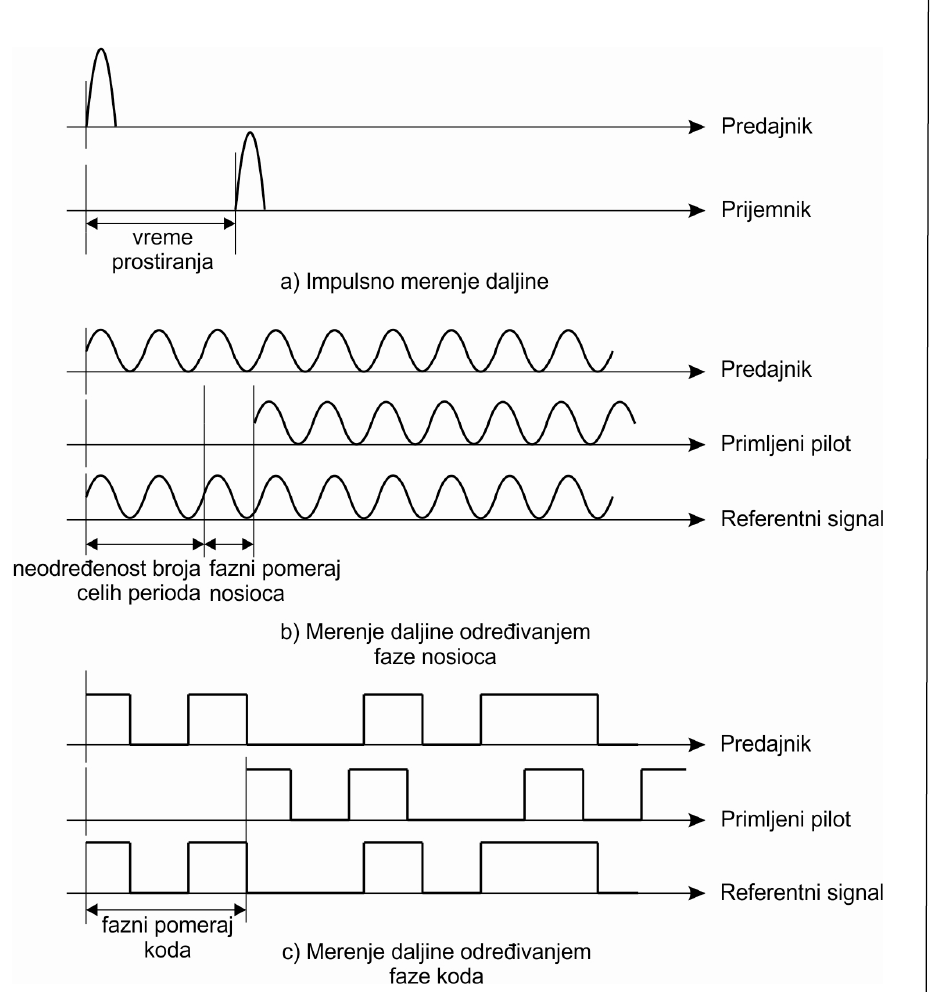
Figure 7 – Ilustration of the local parameters measurement in the time domain Vreme dolaska (Time of Arrival -